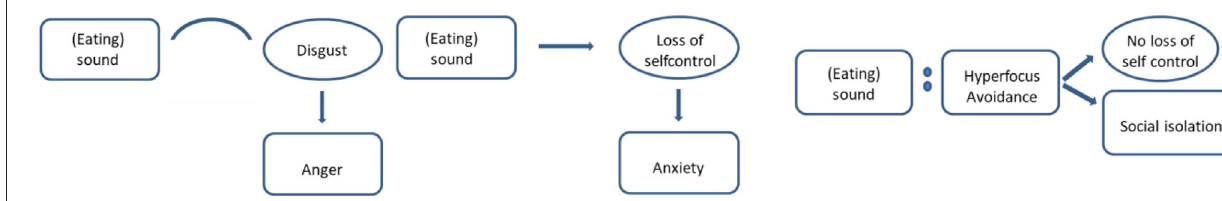
FIGURE 1 | CBT conceptualization of misophonia.